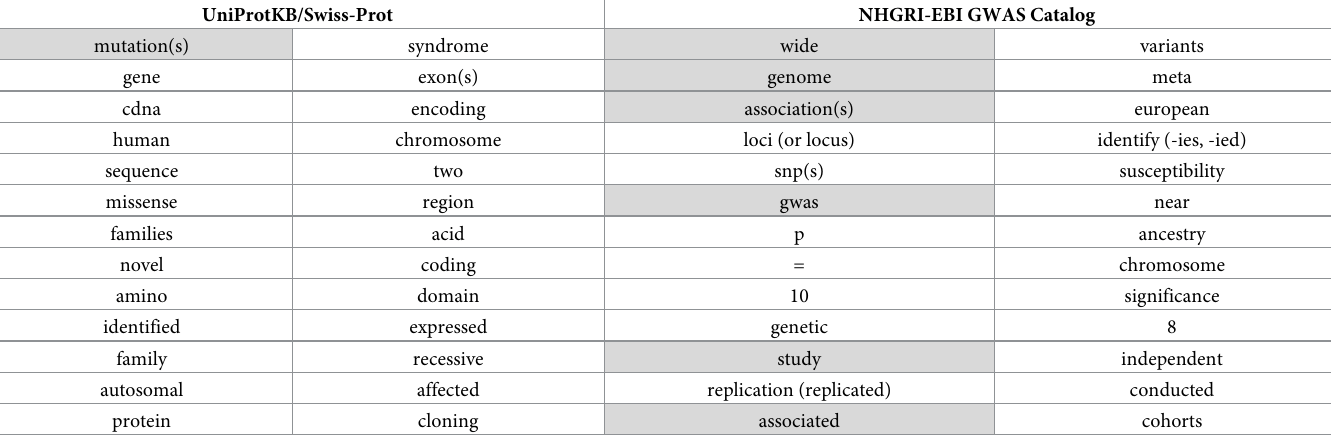
Table 2. Lists of the most significant words in the positively classified publications. (The words that are used as queries in the query-based method of each database are highlighted.).